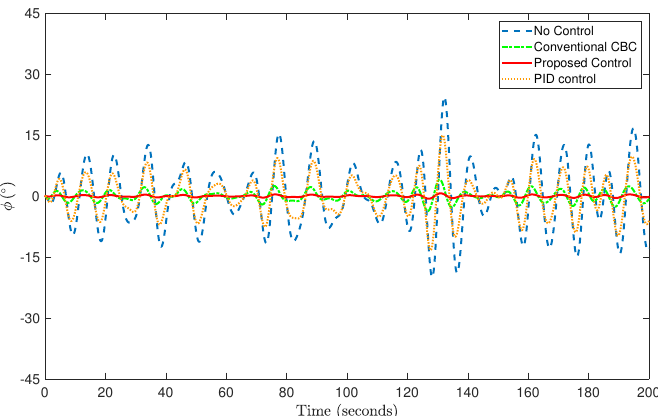
Figure 6. The time curves of ship rolling angle with different control methods.